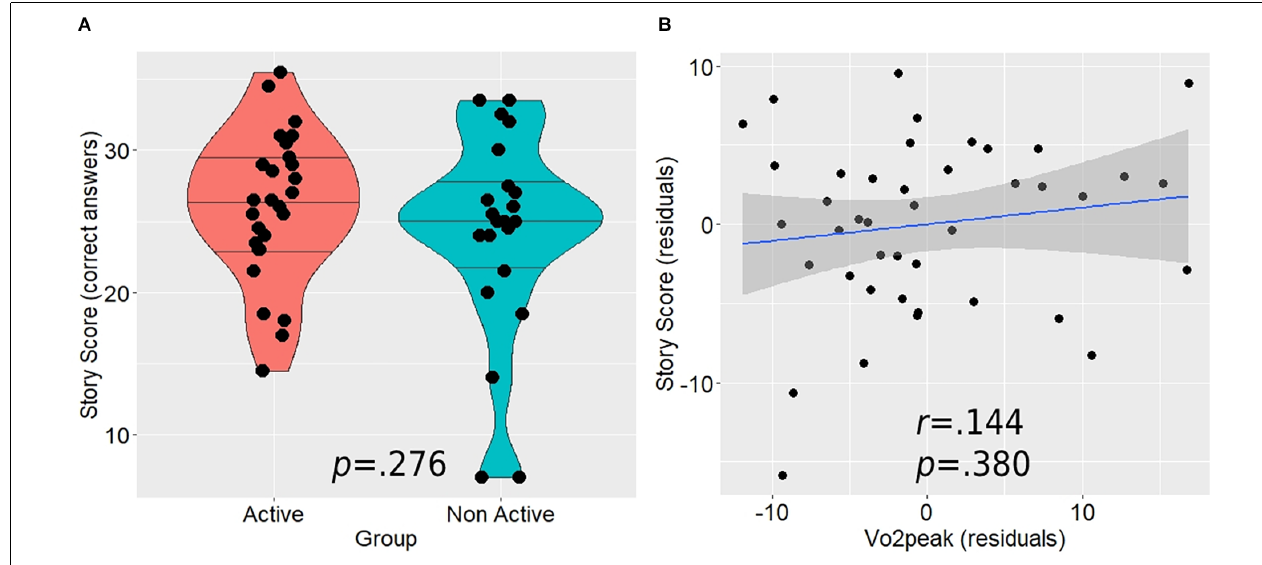
FIGURE 5 | The relationship between the post-scan story score, aerobic activity level (A) , and Vo 2 peak (B) . Horizontal lines in between group violin plot (A) represent 25%, 50%, and 75%